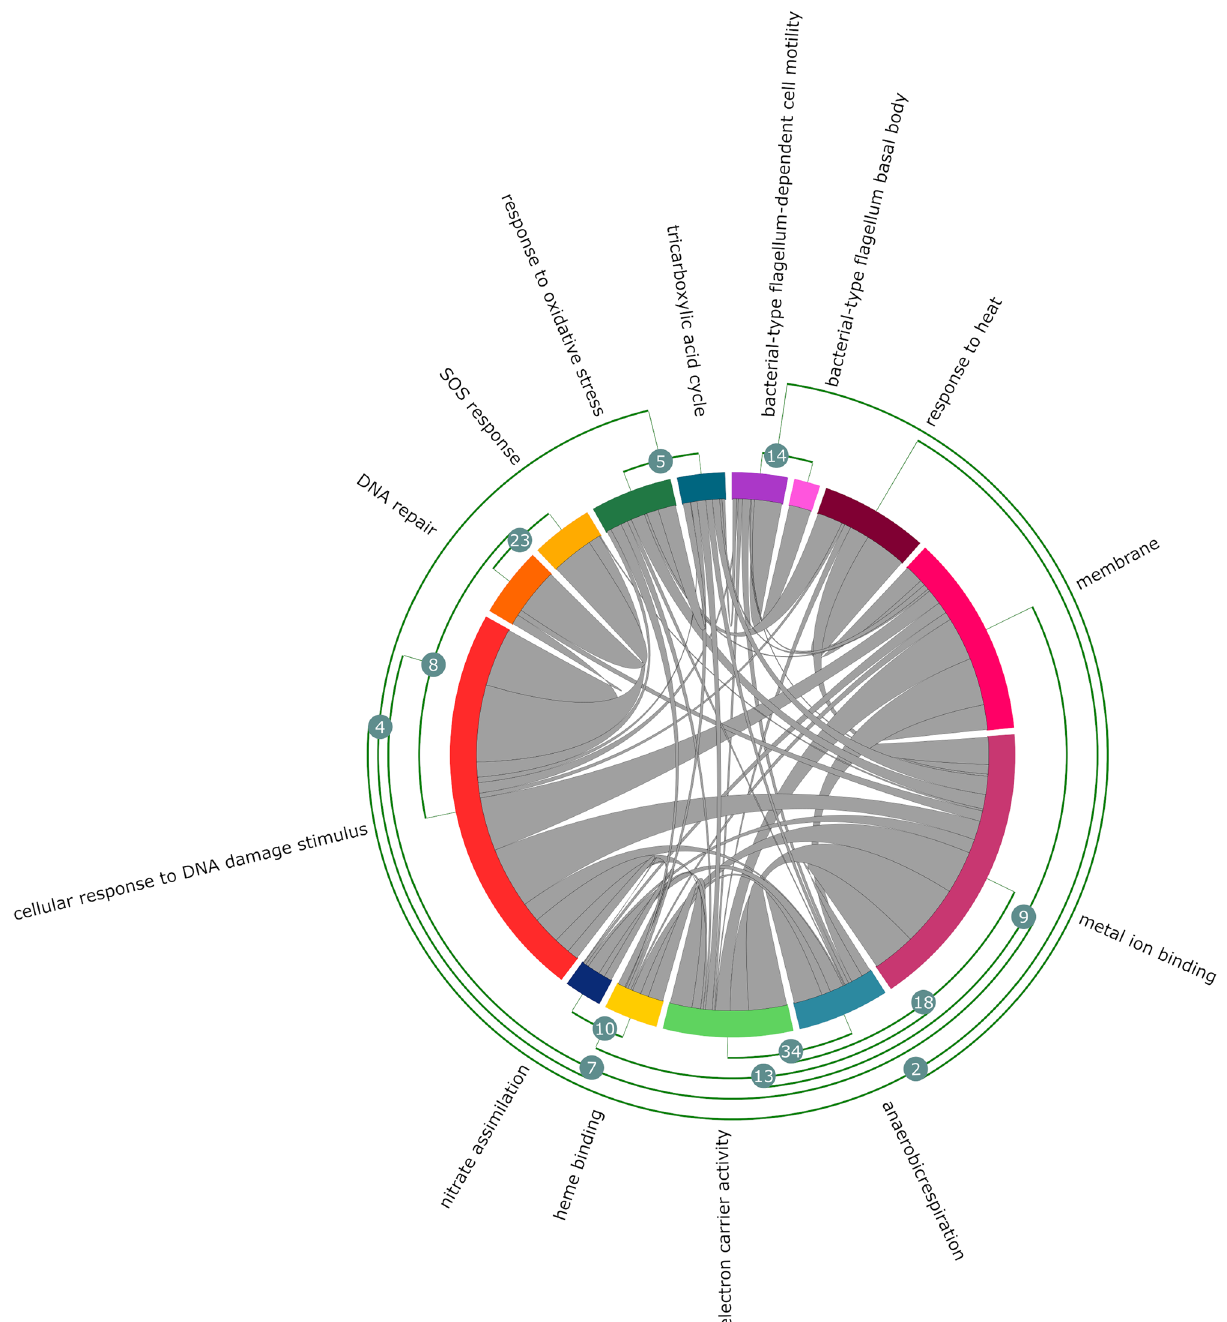
Figure 2. Cross-talk between significantly enriched GO annotations in SRN. Chord diagram depicting the connections between significantly enriched GO annotations ( P adj < 0.01). The fragments on the outer ring of the circular layout represent the nodes/GO annotations. The nodes are clustered based on the number of overlapping genes. The curved arcs within the circle show the interactions between different orange module (Fig. 3). The orange module is associated with processes like SOS response, cellular response to DNA damage, stress, and external stimulus (Fig. 4c). Genes in the saddle brown module were positively correlated with the low oxygen (LOX) environment (Fig. 3) and were majorly involved in cofactor metabolic processes, iron-sulfur cluster assembly and protein maturation (Fig. 4c). In the KEGG enrichment analysis, 27 pathways were significantly enriched among five of these modules, some of which include microbial metabolism in diverse environments, quorum sensing and phosphotransferase system (PTS) (Fig. 4d). No significantly enriched KEGG terms were found to be associated with the orange and saddle brown module.